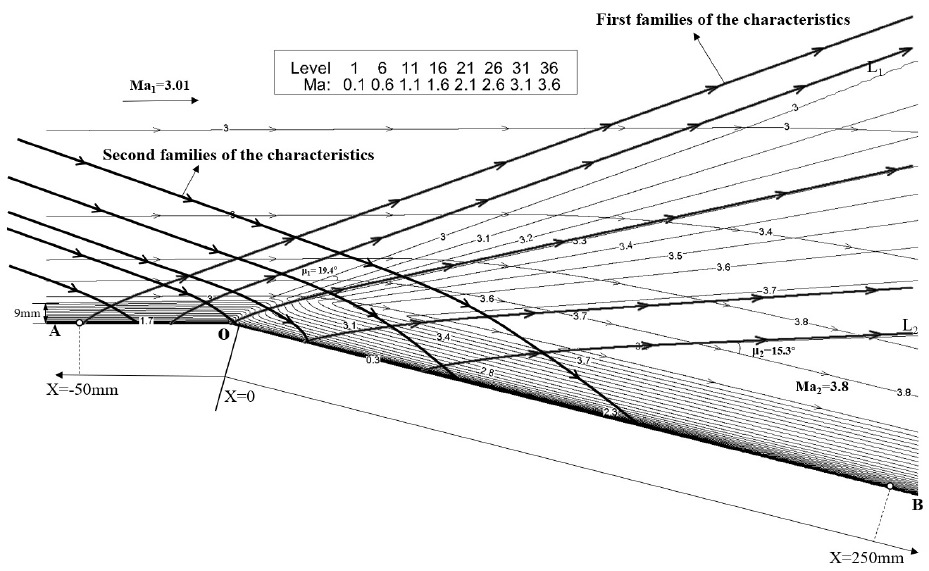
Figure 5. Characteristics in the Mach number contour